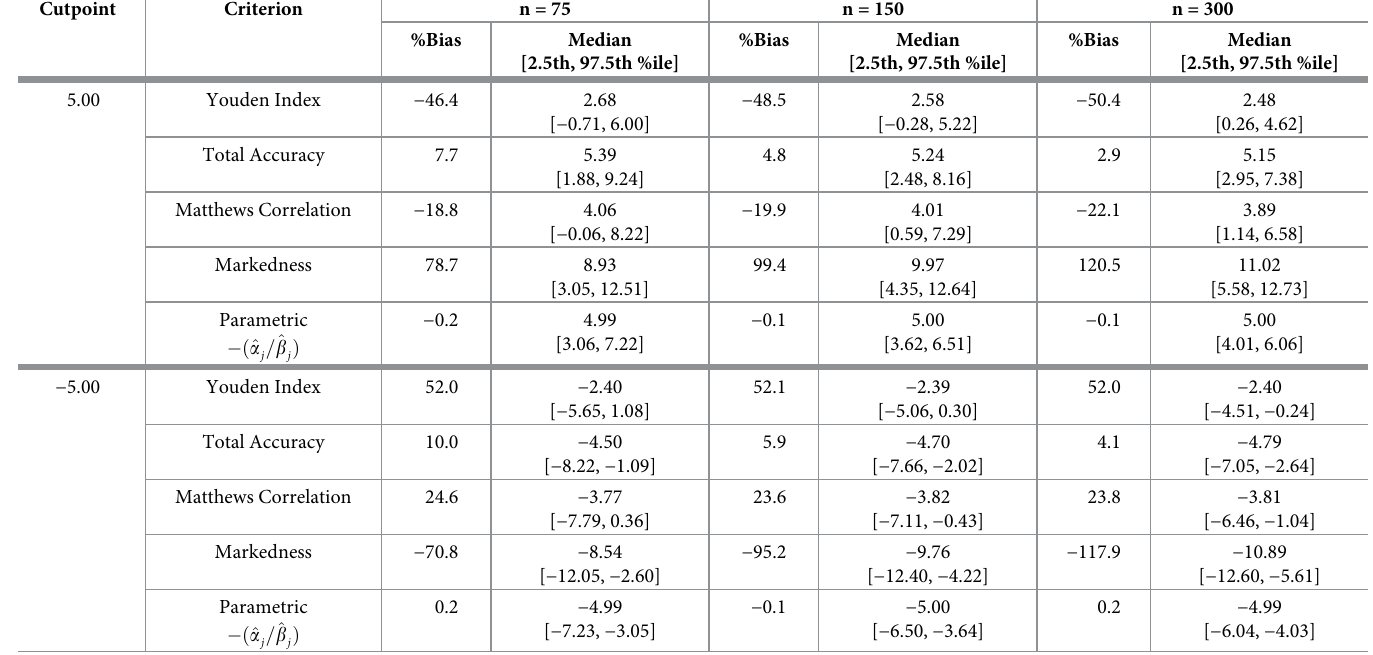
Table 5. Proportional odds simulation. Percentiles and biases of cutpoints selected from cumulative ROC curves with several criteria and computed parametrically: 10,000 simulated datasets parameterized for proportional odds and AUC 1 = AUC 2 = 0.90. Cutpoint